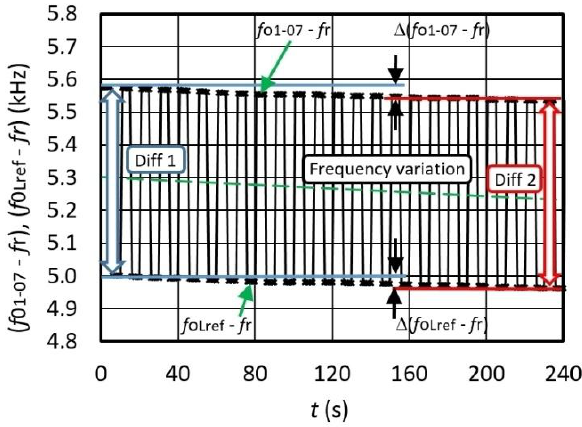
Figure 8. Extended temperature dynamic (switching mode) frequency instability for f 01–07 − f r and f 0Lref − f r (sensitivity is 31.58 kHz) (temperature change from 0 to 50 °C).